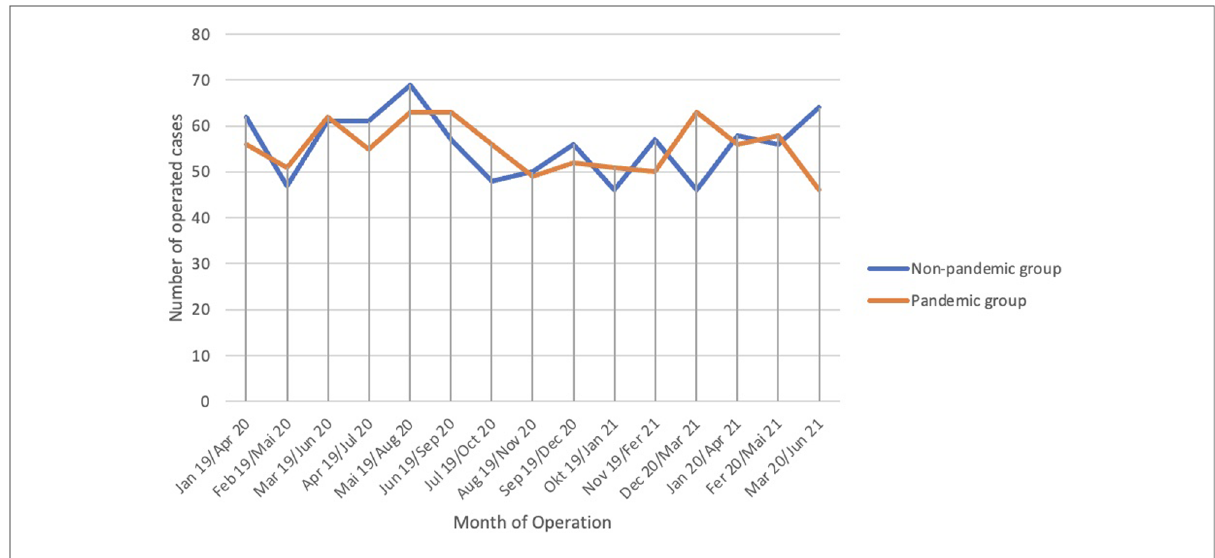
FIGURE 1 Timeline with the number of cases in the non-pandemic and pandemic group.